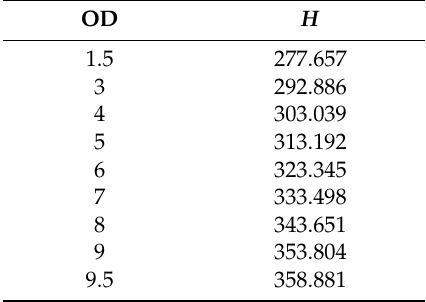
Table 5. The predicted mean values of H